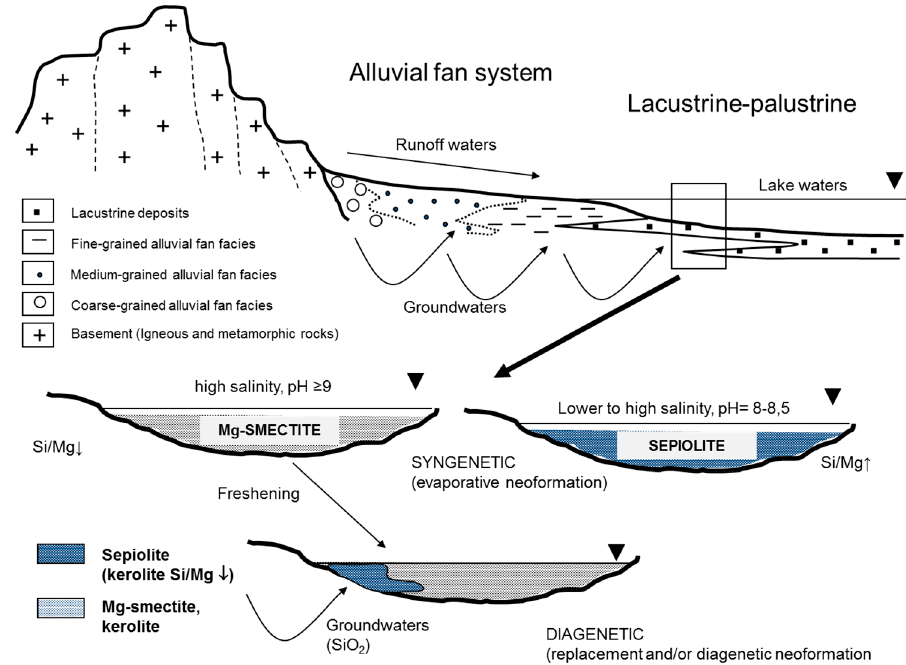
Figure 9. Idealized models proposed for the formation of sepiolite, stevensite and kerolite deposits in continental sedimentary environments (from [78]).